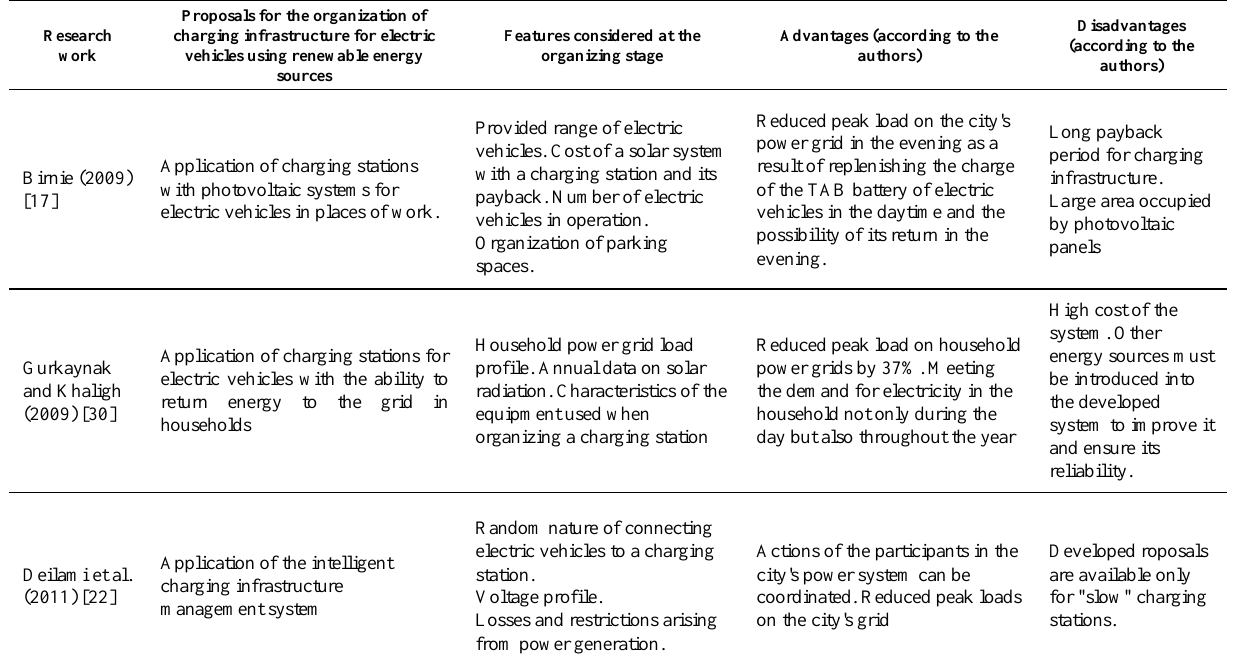
Table 1. Analysis of publications on the use of renewable energy sources in the organization of electric vehicles charging